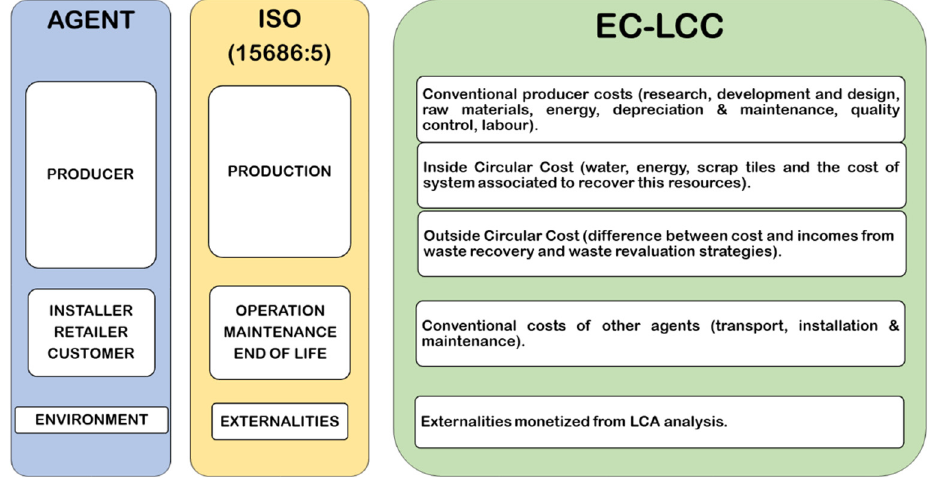
Figure 3. EC-LCC scheme (source: our